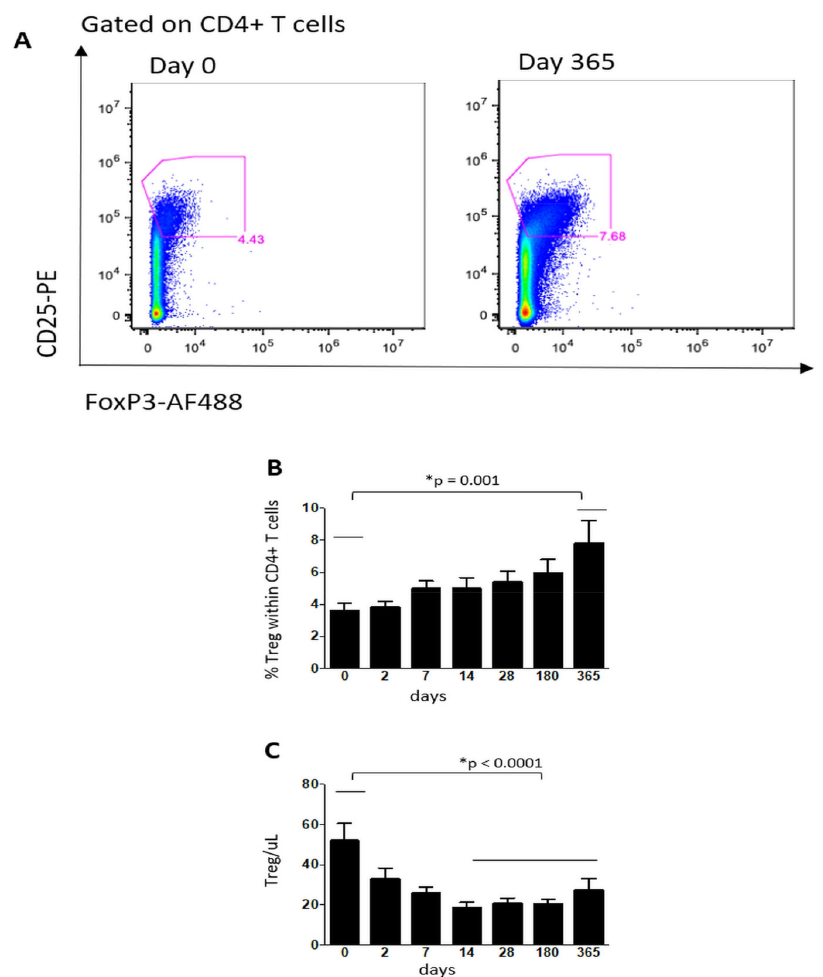
Figure 2. Representative dot plots showing the percentages of Treg cells for the same patients before and after 1 year of therapy (panel A ). Percentage among CD4+ cells (panel B ) and absolute numbers (panel C ) of Tregs derived from MS patients before starting fingolimod (0) and at different time-points throughout one year. Data are represented as mean ± standard error of the mean. N = 36 patients throughout days 0–28, N = 28 at 180 days and N = 20 at 365